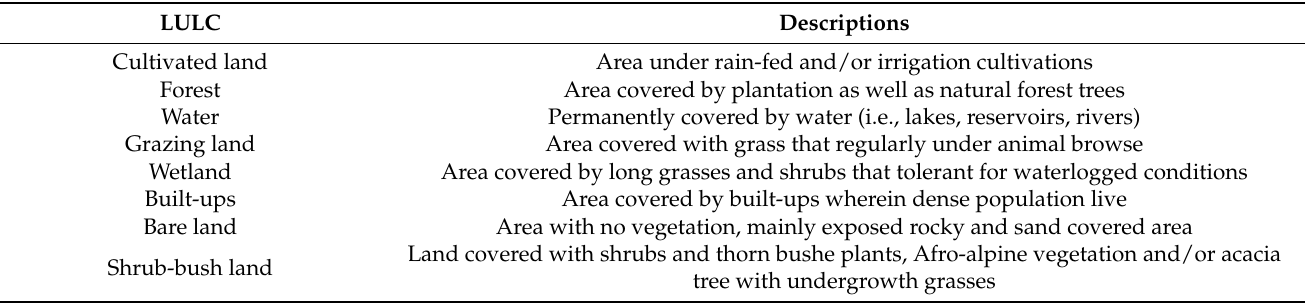
Table 1. Description of LULC